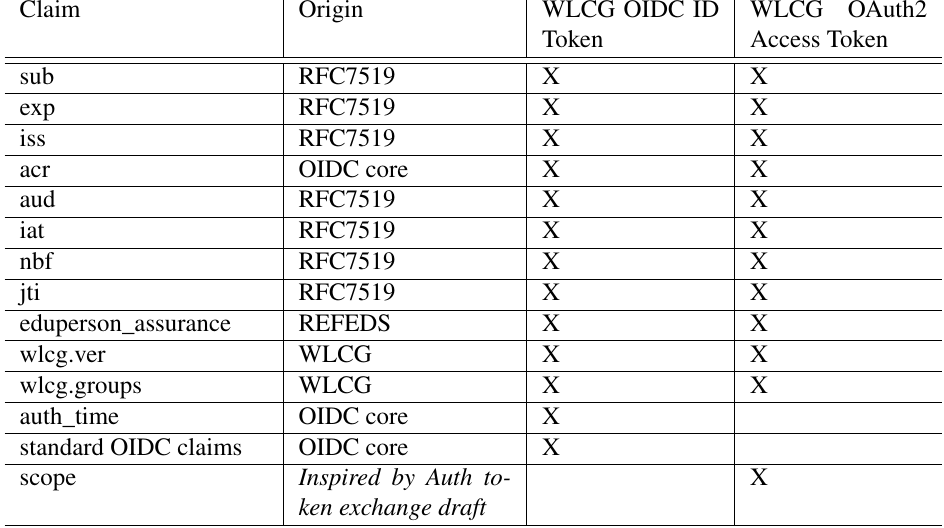
Table 1. Token Claims used in the WLCG Schema, including their origin in either RFC7519 [4], OIDC core [5], the Research and Education Federations (REFEDS) [24] or the WLCG Schema itself [21].“X” indicates their use in ID and Access tokens. Claim definitions can be found at the origin and are not included here for